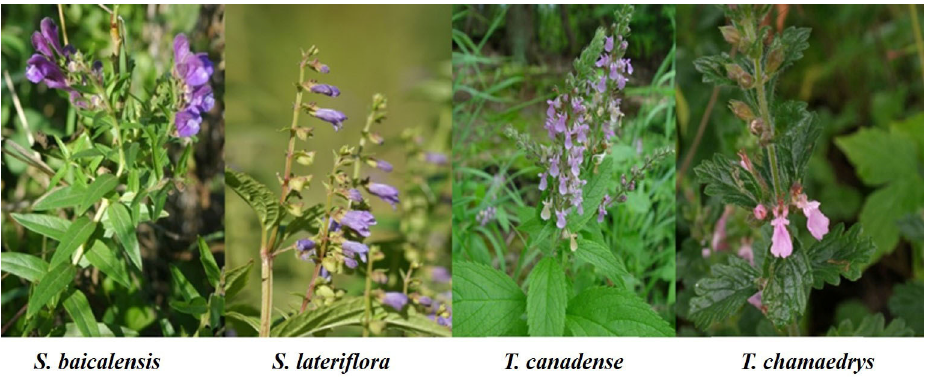
Figure 7. Morphological similarities between Scutellaria and